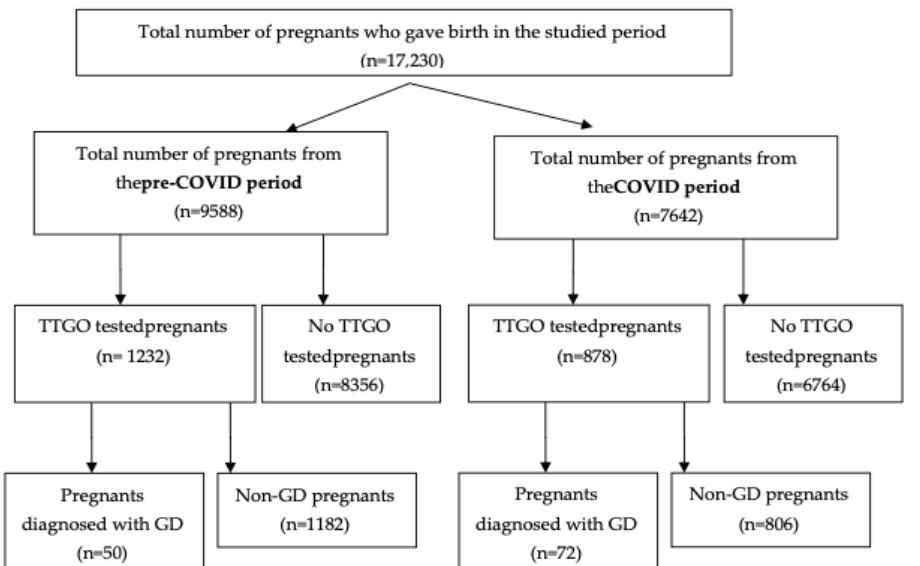
Figure 1. Flowchart describing patient selection; GDM: gestational diabetes mellitus